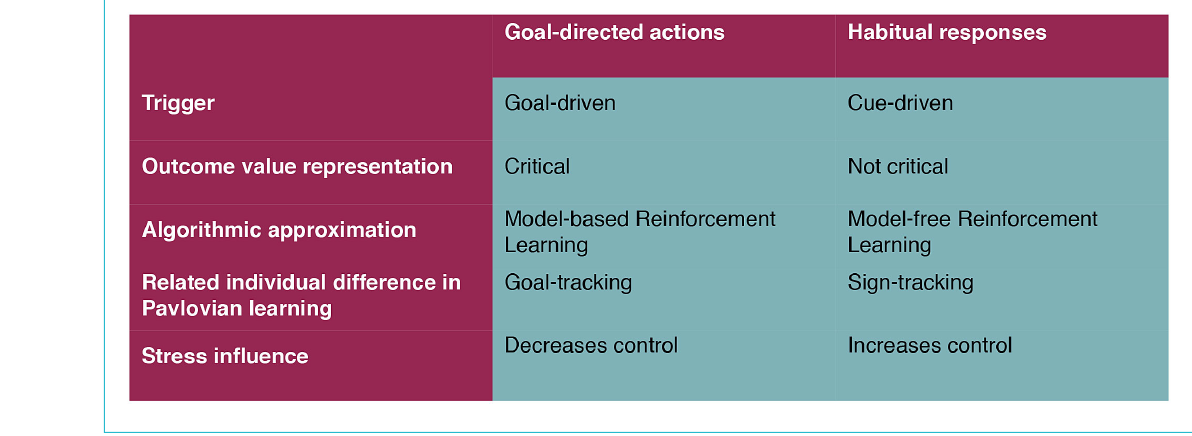
Figure 4: Schematic summary of the described differential mechanisms relative to goal-directed actions versus habitual